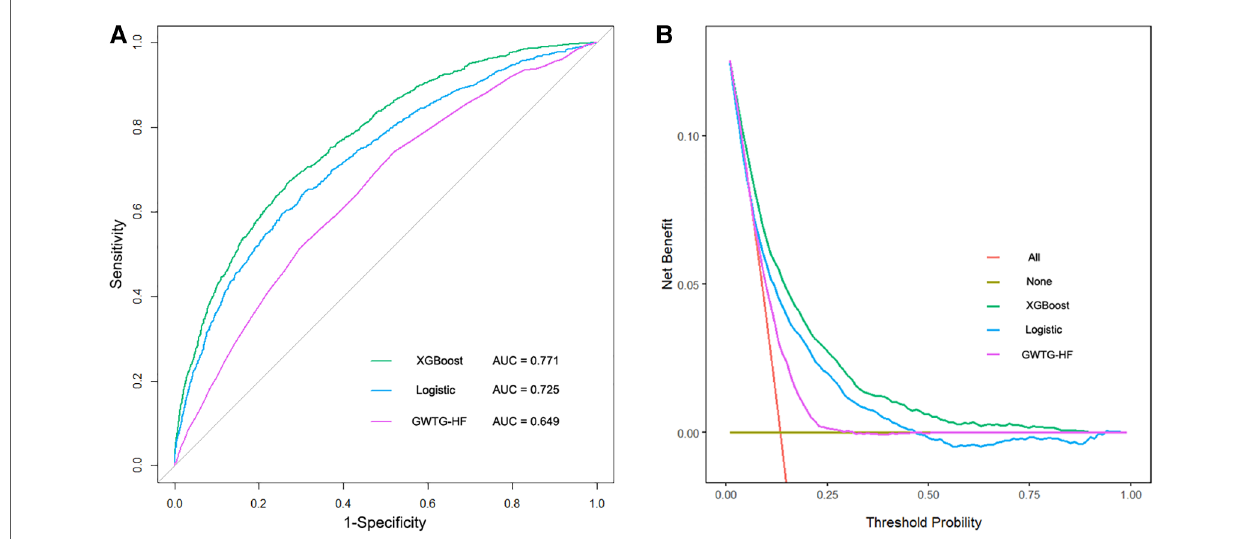
FIGURE 4 The receiver operating characteristic curves and the decision curve analysis of all models in test dataset. ( A ). The brown transverse line=net bene fi t when all patients are considered to not have the outcome (in-hospital all-cause mortality); red oblique line=net bene fi t when all patients were considered to have the outcome; the decision curve analysis of all models showed that the proportion of the bene fi t for the population was the highest when the risk assessment of the XGBoost model was used for treatment, while the treatment threshold probability was from 0% to 90% ( B